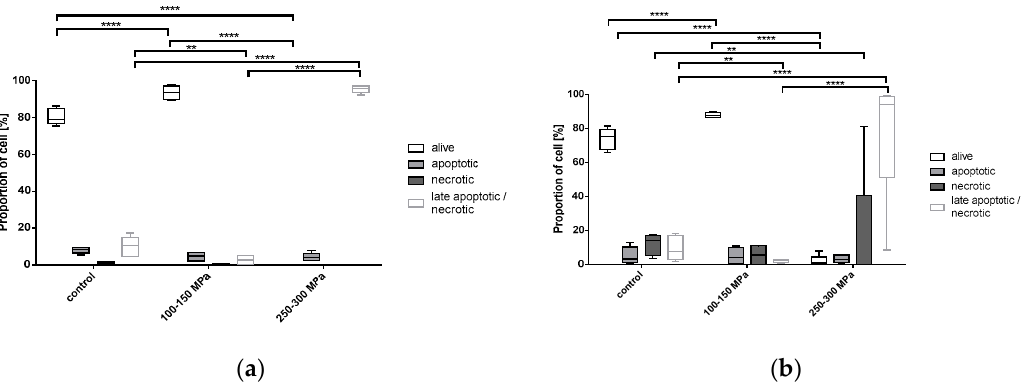
Figure 4. Analysis of cell death detection after HHP treatment (100–150 MPa and 250–300 MPa, 10 min) of ( a ) human osteoblast cell pellets ( n ≥ 4) and ( b ) human chondrocyte cell pellets ( n ≥ 5) with